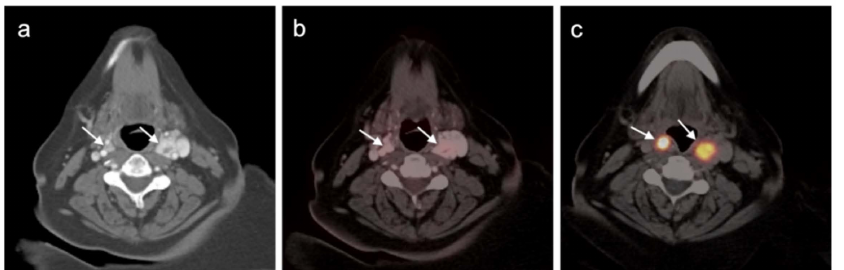
Figure 44. Bilateral carotid body paragangliomas with comparison contrast-enhanced CT and FDG and [ 68 Ga]Ga-DOTA-TATE (NETSPOT ® ) PET-CT scans. ( a ) Axial intravenous contrast-enhanced CT image of the upper neck shows strongly enhancing bilateral nodules in the carotid space at the carotid bifurcation (white arrows). ( b ) Axial image of the upper neck with a concurrently acquired FDG PET-CT shows that the nodules exhibit relatively low metabolic activity (white arrows). ( c ) Axial [ 68 Ga]Ga-DOTA-TATE (NETSPOT ® ) image of the upper neck shows that the nodules demonstrate intense activity (white arrows). Paragangliomas are reliably strongly positive on SSTR PET-CT but are variable in terms of metabolic activity on FDG